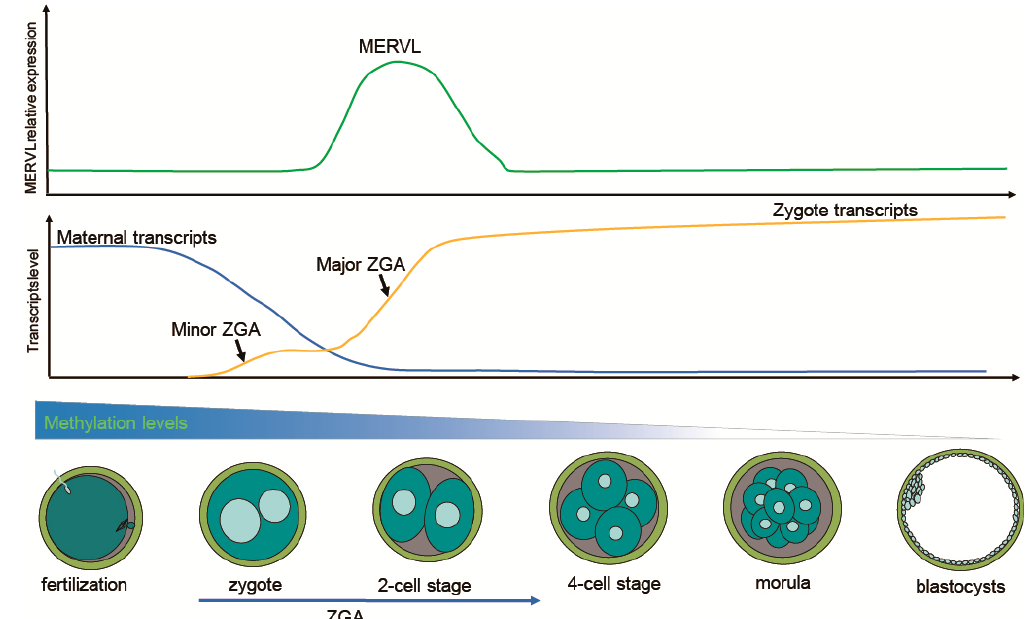
Figure 1. Schematic illustration showing the dynamics of transcription and DNA demethylation during murine pre-implantation embryo development. Shortly after fertilization, embryos undergo extensive global DNA demethylation from the zygote to the blastocyst. Degradation of maternal transcripts is required for ZGA. Minor ZGA occurs at the one-cell stage, while major ZGA takes place at the two-cell stage. Particularly, the expression of MERVL peaks at the two-cell stage, and then gradually decreases until the blastocyst stage.